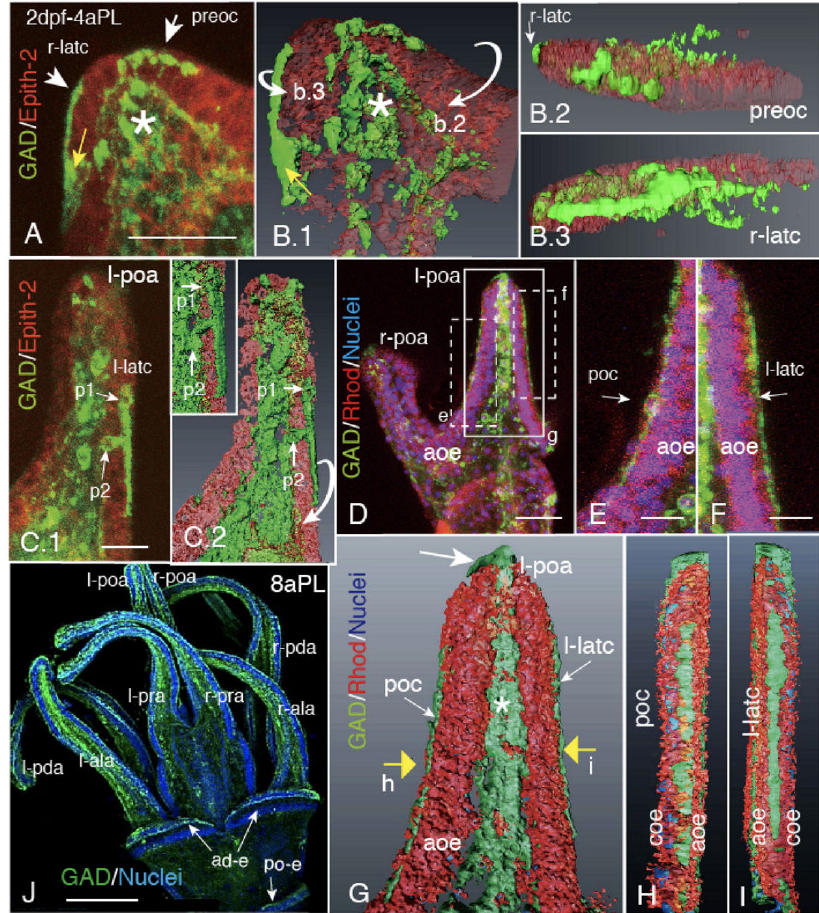
Figure 1. CBAS patterning process during the 4aPL stage. ( A ) Confocal laser scanning microscopy (CLSM) of the right antero-lateral arm showing a mass of blastocoelar GAD-positive cells (GADC, asterisk) egressed in part onto the larval body surface at the arm tip (arrows). ( *B.1 ) 3D-reconstructed image of (A). Part of the egressed GADCs extend as a fragmental stripe of preoral CBAS (preoc) on the apical surface of the antero-lateral arm tip. The other GADCs are egressed onto the other direction and extended to form a short preoral CBAS (preoc). ( B.2 ) Rotated image of (B.1) toward the direction shown by a curved arrow, b.2, in (B.1), showing the fragmental stripe of preoral CBAS. Part of the right lateral CBAS is seen (r-latc). ( B.3 ) Rotated image of (B.1) as shown by the curbed arrow b.3 in (B.1). GADCs extend as a stripe on the larval arm surface. ( C.1 ) CLSM image of the left post-oral arm. A posteriorly extended fragmental CBAS (l-latc) retains perikarya on the apical surface (p1) and basally in the ectoderm (p2). ( *C.2 ) 3D-reconstructed image of (C.1). (C.2, inset) Rotated image of (C.2) as shown by a curbed arrow. ( D ) CLSM of the oral side of the larva shows the left- and right-post-oral arm region (l-poa, r-poa). Two CBASs are seen between the aboral ectoderm (aoe) and the circumoral ectoderm (coe). ( E ) Higher magnification of the post-oral CBAS (poc) with perikaryon, shown by a rectangle (e) in (D). ( F ) Higher magnification of the left lateral CBAS (l-latc), shown by a rectangle (f) in (D). (* G ) Aboral view of 3D-reconstructed image of the same area, as shown by a rectangle (g) in (D). The poc and the l-latc are separated from the blastocoelar GADCs (asterisk), while some blastocoelar GADCs are egressed at the tip of the arm (arrow). ( H ) The poc in (G), viewed from the direction shown by a yellow arrow (h) in (G). ( I ) The l-latc shown in (G), viewed from the direction shown by a yellow arrow (i) in (G). ( J ) Fully formed circumoral CBAS and those on the oral side antero-dorsal-epauletes (ad-e) and posterior-epaulet (po-e). * Refer to Supplemental Figure S1(B.1,C.2,G). Scale bars = 25 µ m (A, C.1 ), 10 µ m (D–F), 100 µ m